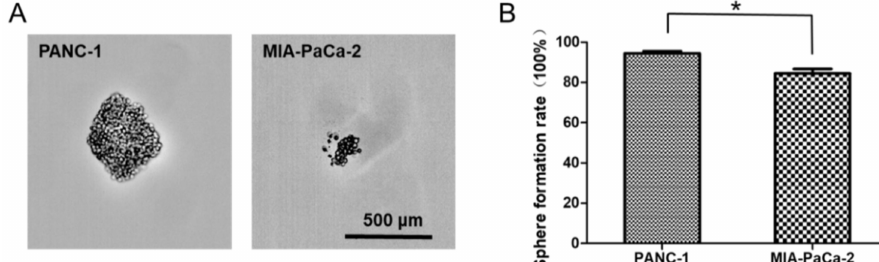
Figure 5. The sphere formation ability of PANC-1 and MIA-PaCa-2. ( A ) Sphere images of PANC-1 and MIA-PaCa-2 cells after nine days culture. ( B ) The di ff erence of sphere formation rate between PANC-1 and MIA-PaCa-2 cells. Data are presented as the mean ± standard deviation (SD) of three independent experiments. * P < 0.05 in comparison with the corresponding cells using Student’s t